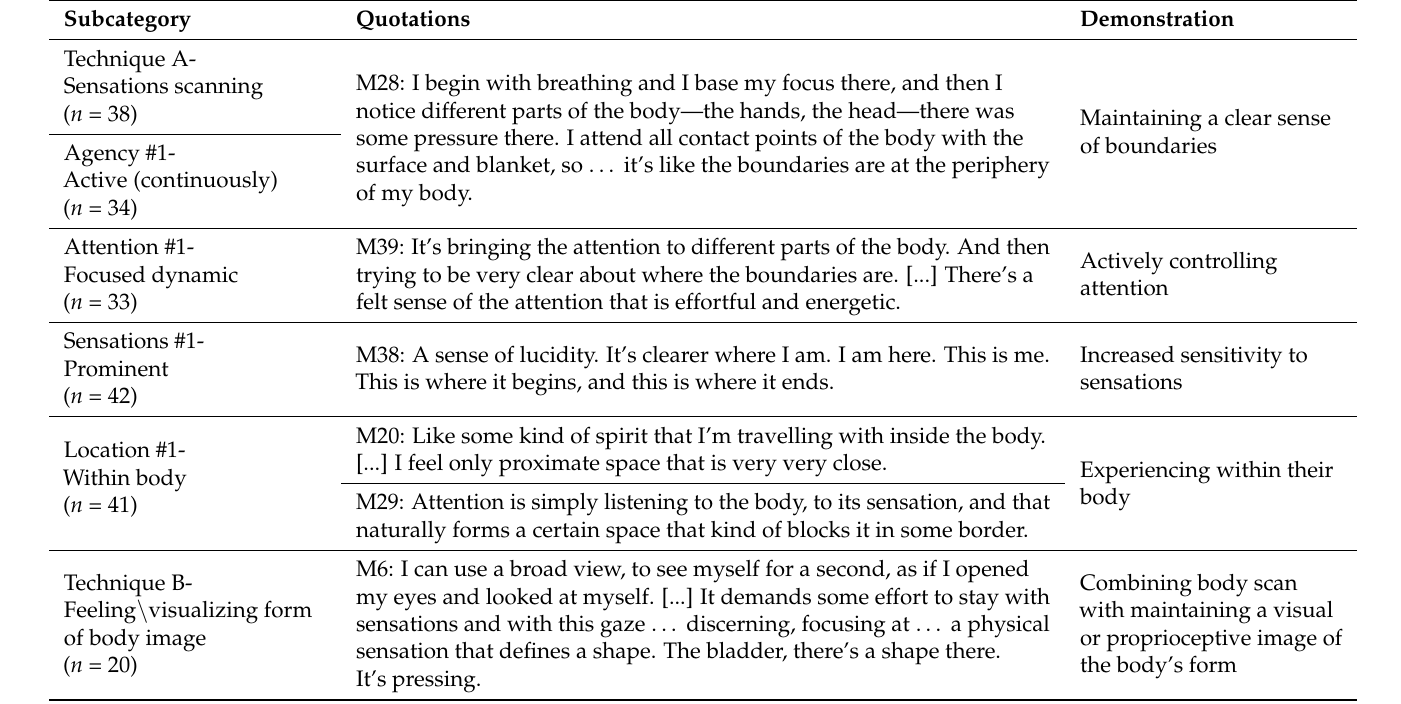
Table 3. Examples representative of prototypical SB+